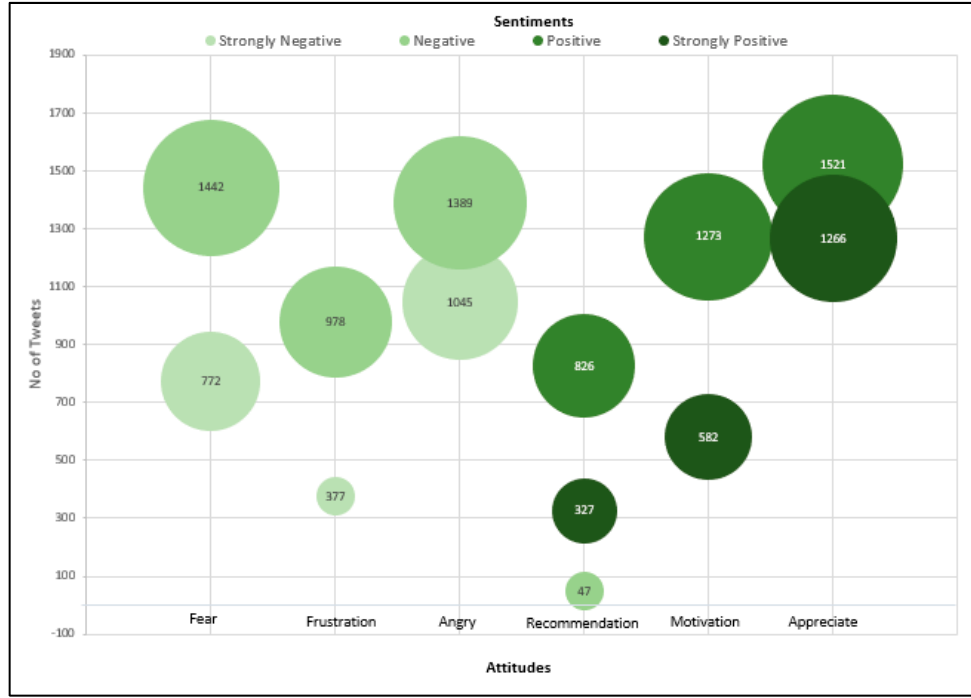
Figure 7. Distribution of tweets by sentiments and attitude clusters. Table 4. Example tweets by sentiments and